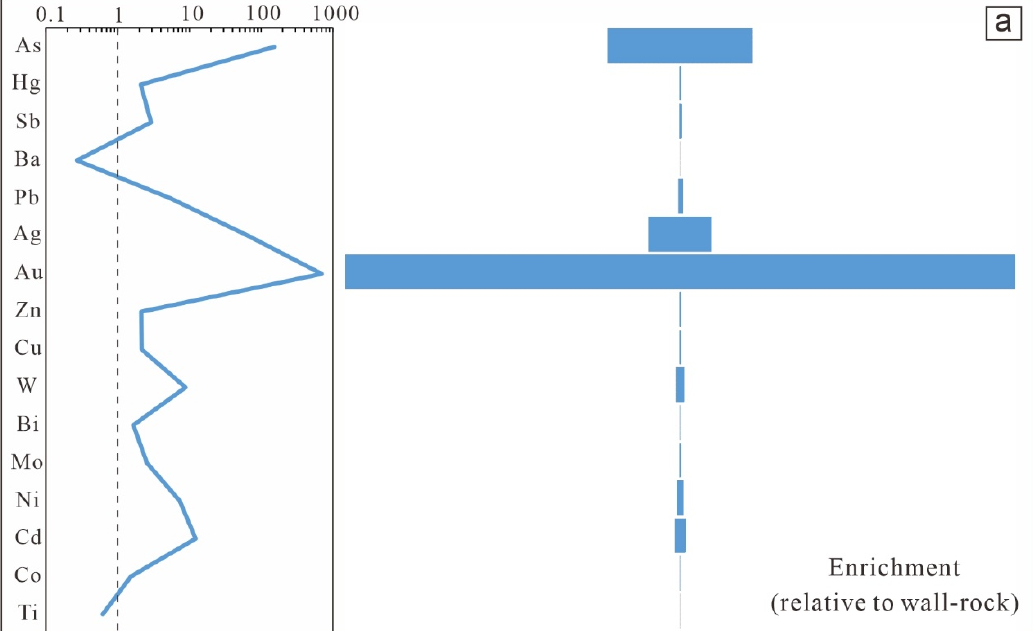
Figure 13. Elemental enrichment in the Yanjingou ore body relative to the wall-rocks and Wulonggou Au district. a: elemental enrichment relative to the wall-rocks; b: elemental enrichment relative to the Wulonggou Au district. 6.2. Implications for Prospecting from in situ Pyrite Thermoelectricity Pyrite is a semiconductor mineral with a band gap of 0.95 eV, which usually has two semiconductor properties: P-type (hole conduction) and N-type (electron conduction) [40,53]. The thermoelectric coefficient α value and conduction type of pyrite are affected by homogeneously distributed impurities in the pyrite, defects in the crystal structure, density, and external excitation conditions (i.e., temperature and pressure gradients). Since these factors are affected by mineralization depth, the thermoelectric properties of pyrite can be used as an indicator of depth [40,41,48,54]. Pridmore and Shuey (1976) showed that the lattice of As-containing pyrite is larger than that of free pyrite, and that P-type conductive pyrite can more readily adsorb Au [38]. The presence of As and Sb can